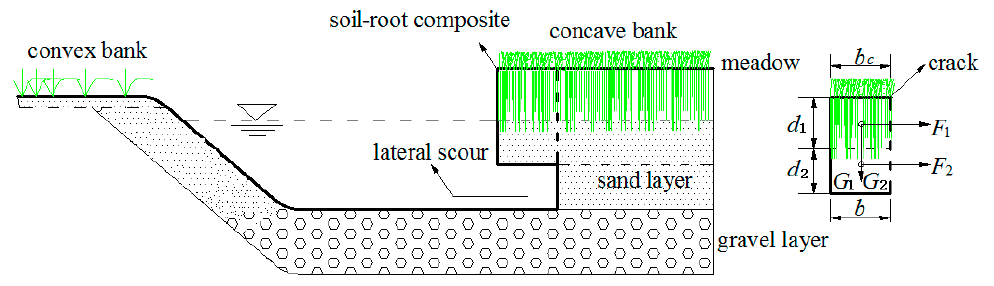
Figure 3. A schematic diagram illustrating the failure of the outer bank as a slump block in the presence of plant roots (green) (refer to section 4 for the meaning of the symbols).